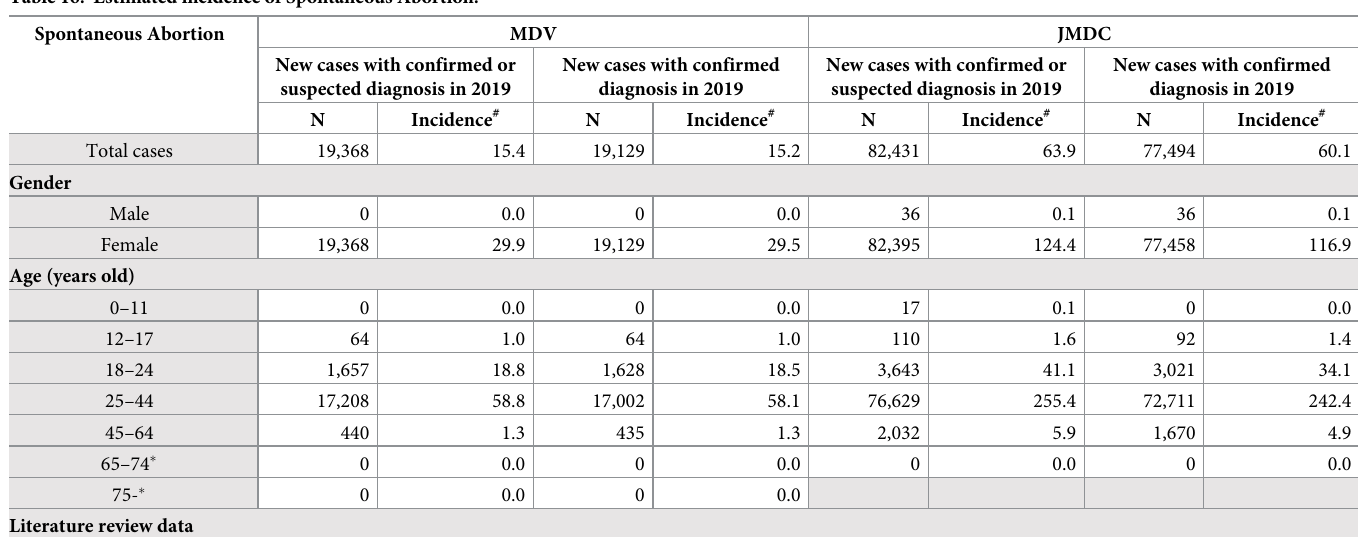
Table 16. Estimated incidence of Spontaneous